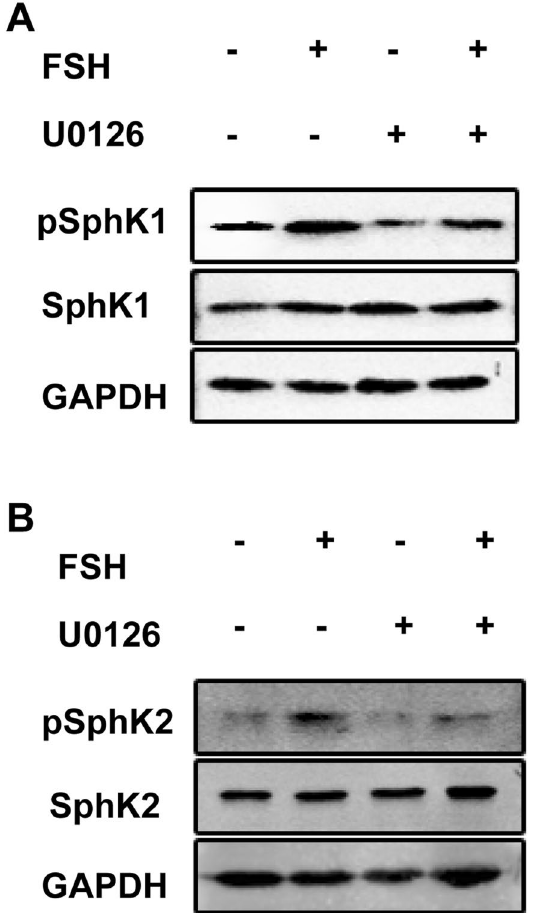
Figure 4. FSH stimulated increase of phosphorylation for SphK1 and SphK2 via Erk dependent pathway. Serum-starved HO8910 cells were pretreated by U0126 (5 µM) for 2 h. And then cells were treated with or without 40mIU/ml FSH. ( A ) At the end of 15 min, levels of pSphK1 were determined by Immunoblotting analysis. Densitometric analysis corresponding to the bands for pSphK1 was shown in the bottom panel (normalized to SphK1 and SphK2, respectively). ( B ) Levels of pSphK2 were determined by immunoblotting analysis. Data are mean ± SD. * P <